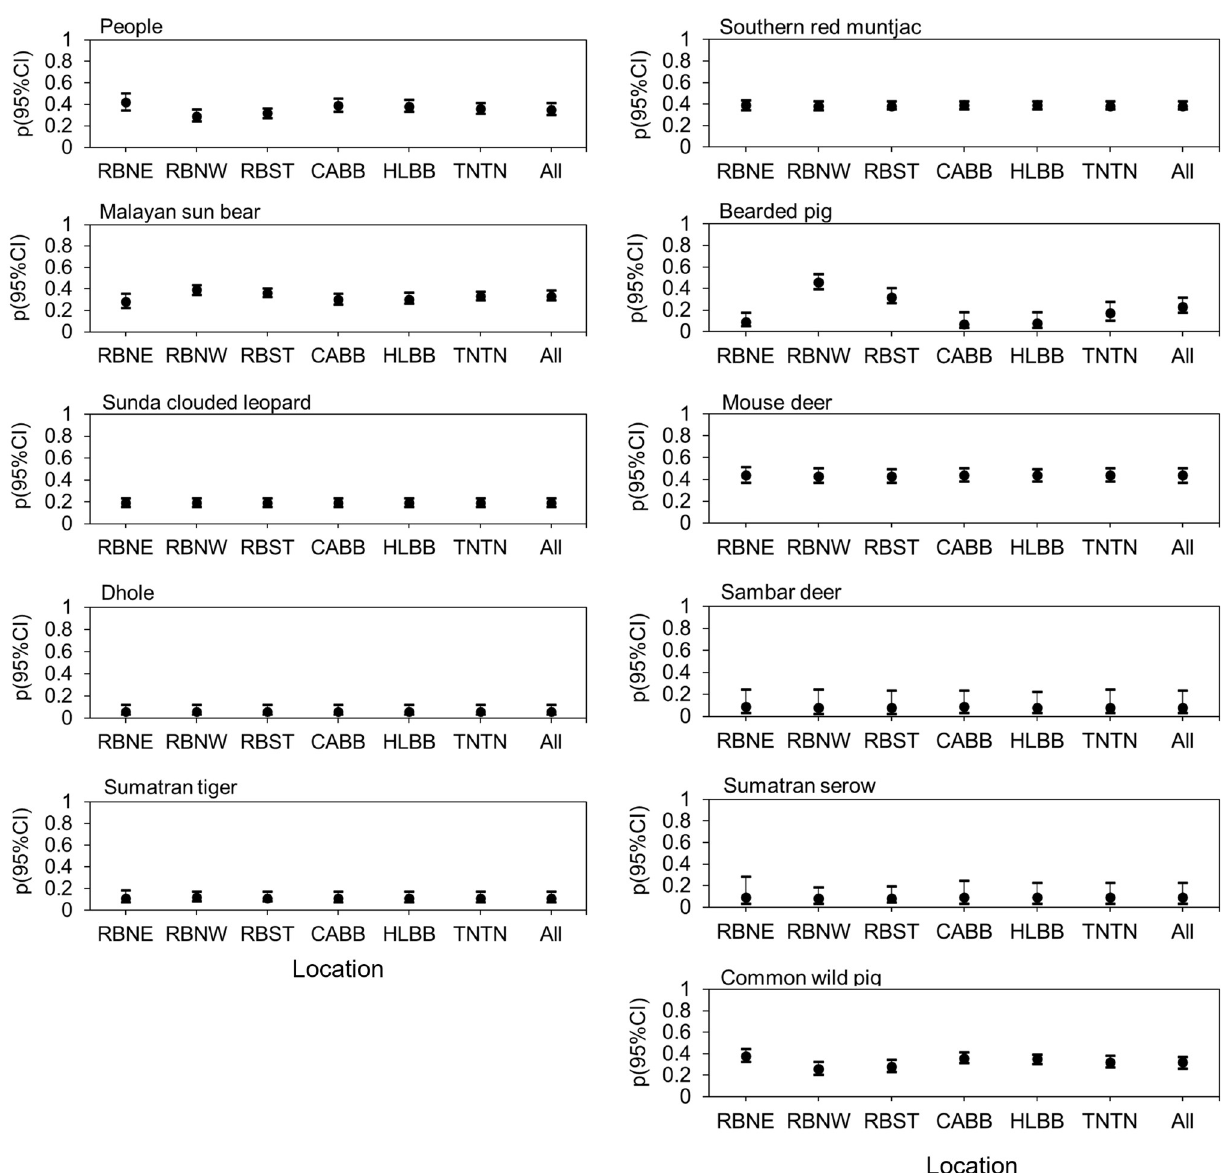
Fig 1. Detection probability with 95% CI based on model averages for top models with Δ AICc � 2: People, large carnivores, and potential prey species for 147 camera stations across all study sites. RBNE, Northeastern Bukit Rimbang Bukit Baling; RBNW, Northwestern Bukit Rimbang Bukit Baling; RBST, Southern Bukit Rimbang Bukit Baling; CABB, Bukit Bungkuk; HLBB, Bukit Betabuh; TNTN, Tesso Nilo; All, “All study